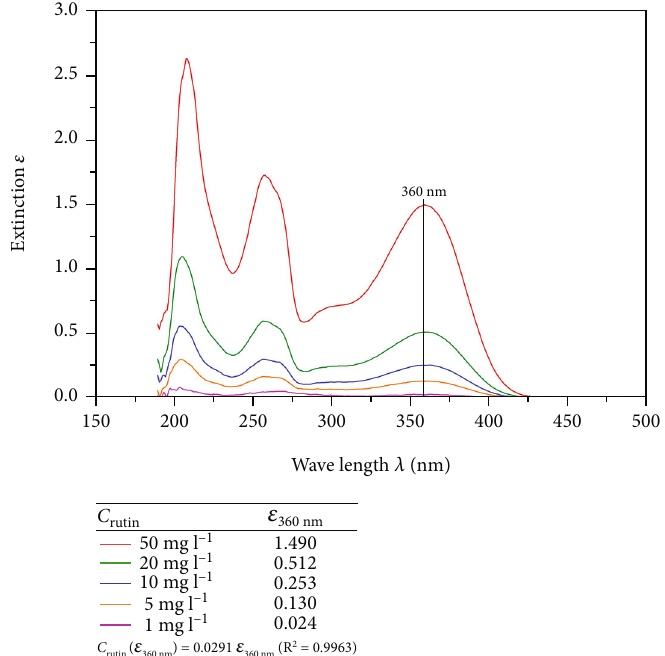
Figure 2: UV-Vis scanning for rutin by variation in the rutin concentration. To calibrate and subsequently measure the extraction samples, the absorbance maximum at a wavelength of 360nm was chosen.